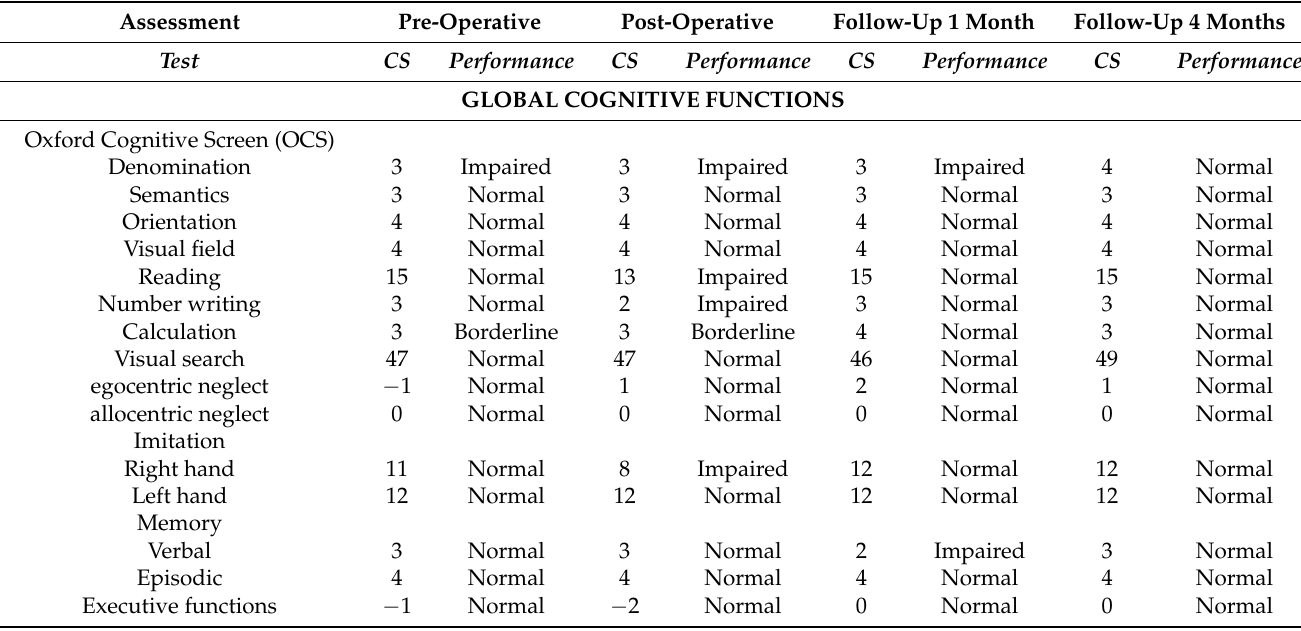
Table 1. Neuropsychological